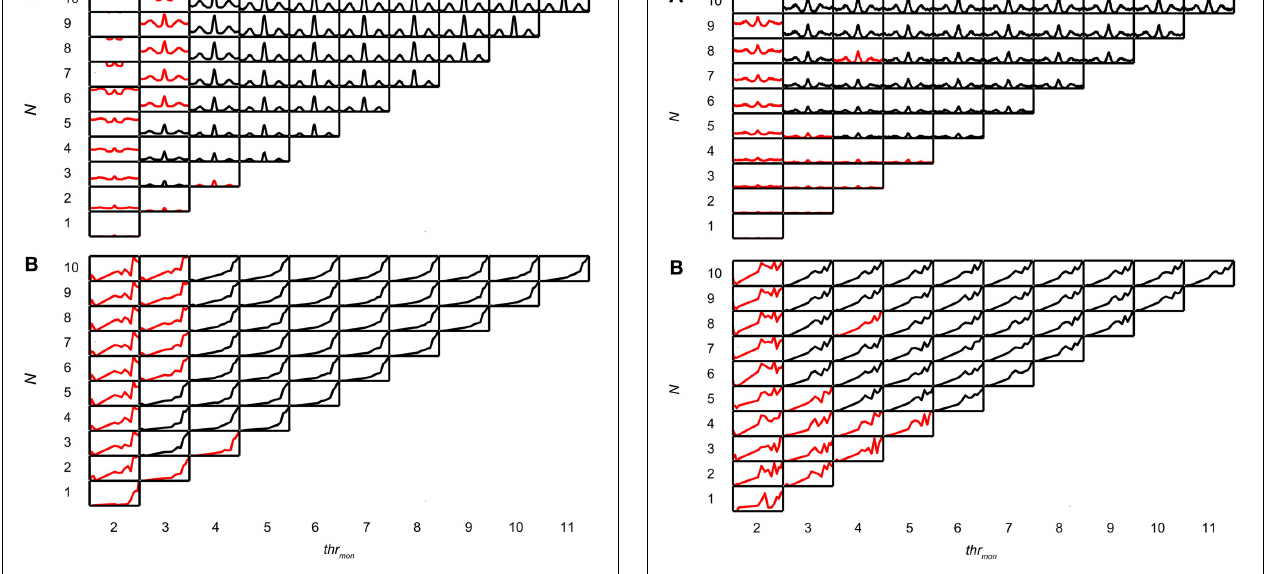
FIGURE 4 | Simulation output for TB dataset. CF = 559Hz. thr bin = 2 and cw = 50 μ s. (A) NDFs to correlated noise, for several values of N and thr mon . For each subplot, delay (abscissa) ranges from − 2.94 to 2.94ms, and coincidence rate (ordinate) ranges from 0 to 170 spikes/s. Black traces indicate accepted simulations, red traces indicate unaccepted simulations (i.e., simulations that fail on at least one acceptance criterion, either for NDF or rICF). (B) rICFs for the same dataset and simulation parameters as in (A) . For each subplot, the abscissa ranges from ρ = − 1 to 1, and the ordinate ranges from 0 to the maximal spike rate of each rICF.